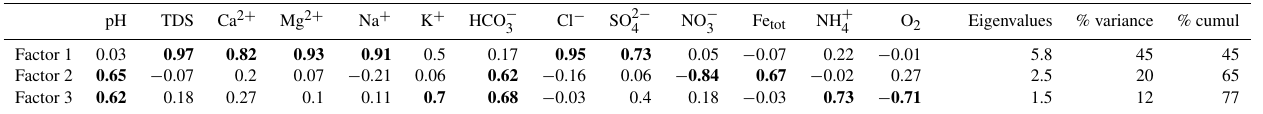
Figure 1. Geological north-south cross-section of Cretaceous-Quaternary sediments (modified after BRGM, 1982 and Sylvain et al., 1986; in Helstrup, 2006 and Gnazou et al., 2011). Table 1. Results of the factor analysis. Bold values represent loadings >